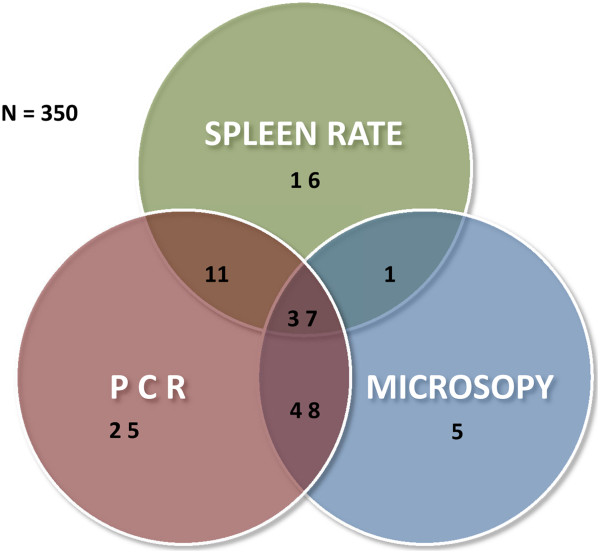
Venn diagram showing relationship between spleen rate, microscopy and PCR positive children aged two to nine years.